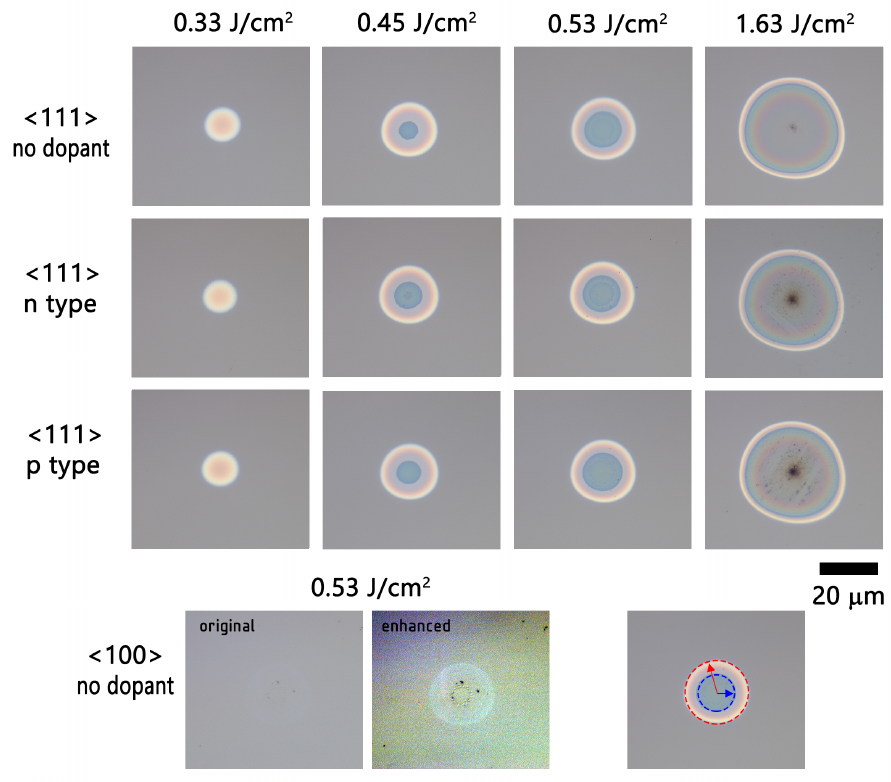
Figure 2. Optical microscope images of silicon crystal following single-shot laser irradiation at various laser fluences. The first three rows depict images for pristine, n-, and p-type (cid:104) 111 (cid:105) crystal while the bottom row shows a typical damage image for (cid:104) 100 (cid:105) crystal, with both the original and contrast-enhanced images provided for clarity. The boundaries of the outer and inner rings are separately marked at the bottom right